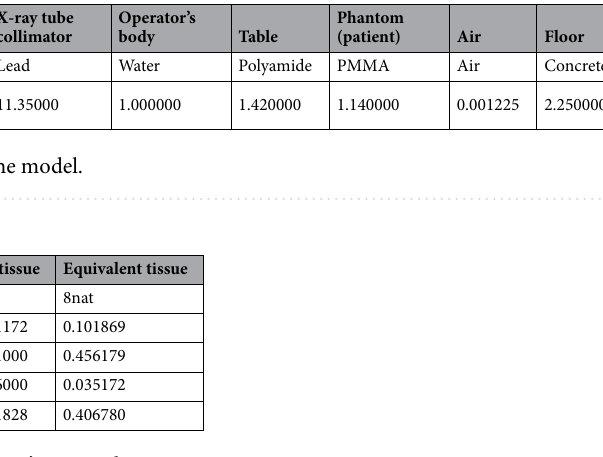
Table 3. MCNP6 weight fractions of the eye’s materials.